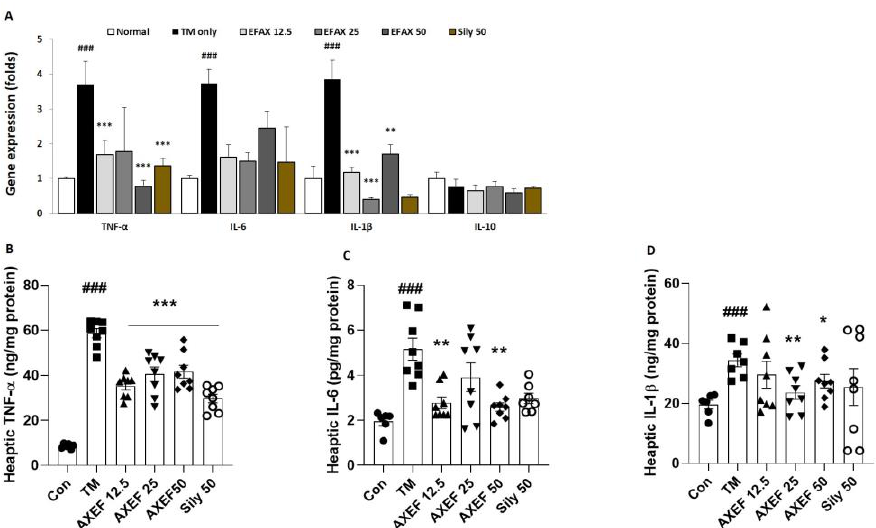
Figure 2. Anti-inflammatory properties of AXEF on the ER stress-induced NASH mice model. ( A ) Hepatic mRNA expression levels of inflammatory response related cytokines, including TNF- α , IL-1 β , IL-6, and IL-10, respectively. ( B – D ) Hepatic protein levels of pro-inflammatory cytokines including TNF- α , IL-1 β , and IL-6, respectively. Data are expressed as the mean ± SD ( n = 6–8 for each group). ### p < 0.001 for the Con vs. TM, * p < 0.05; ** p < 0.01; *** p < 0.001 for TM vs. AXEF or Sily 50.